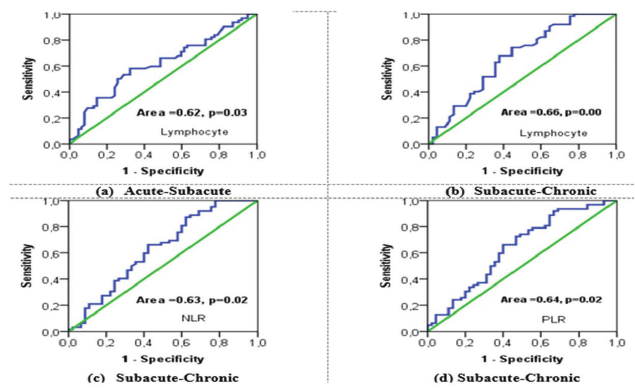
Figure 2 - The results of ROC analysis between the brucellosis subgroups for significant hematological parameters